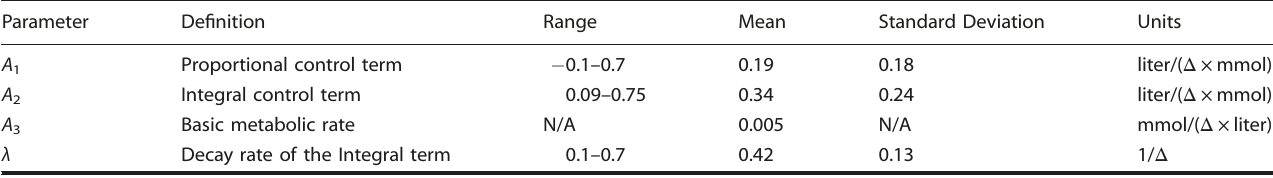
Table 1. Parameters of the glucose homeostasis model with their de fi nition, typical range across test subjects, mean, and standard deviation across subjects after the fi tting procedure described in the Results.